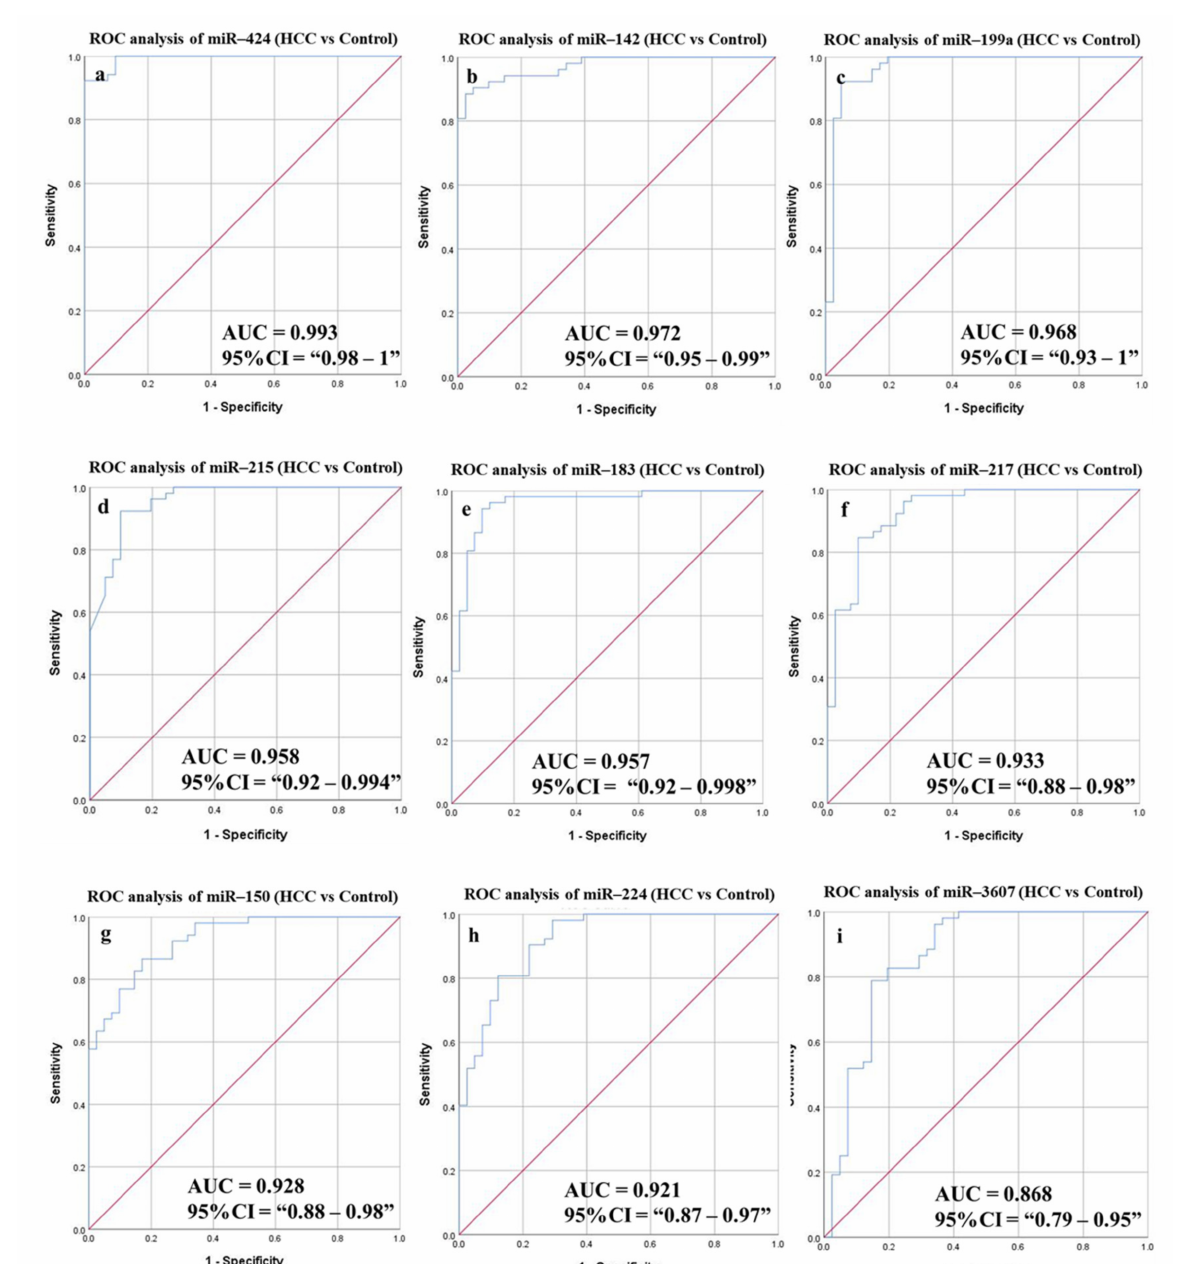
Figure 6. ROC curves and AUC for the DE-miRNAs differentiate between HCC patients and healthy individuals. The diagnostic potential and AUC of nine DE-miRNAs [( a ) miR-424 ( b ) miR-142 ( c ) miR- 199a ( d ) miR-215 ( e ) miR-183 ( f ) miR217 ( g ) miR150 ( h ) miR-224 and ( i ) miR-3607] were calculated. (DE: Differentially expressed, HCC: Hepatocellular carcinoma, ROC: Receiver operating